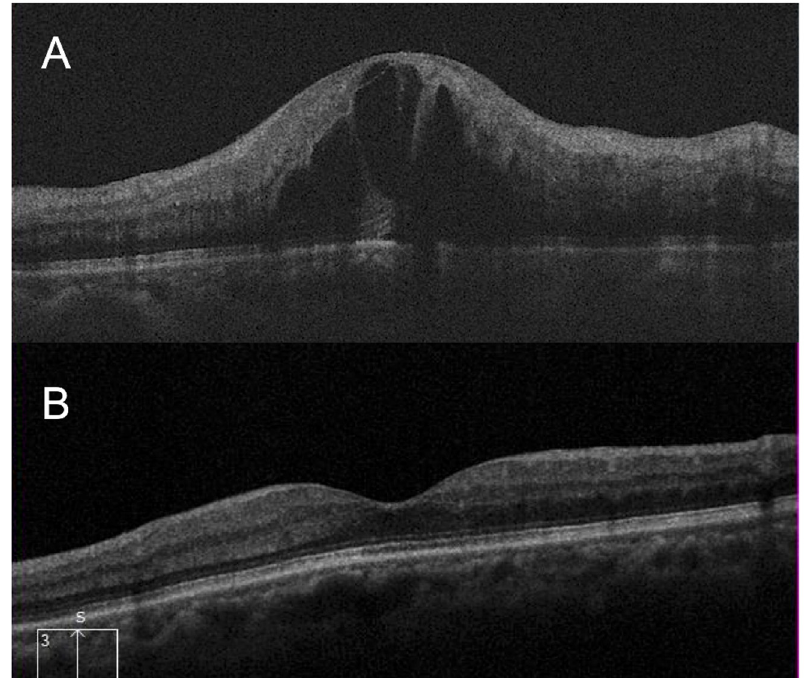
Figure 2. Optical coherence tomography images of a 64-year-old woman with cystoid macular edema secondary to central retinal vein occlusion (CRVO-CME). ( A ) At baseline, CRVO-CME was observed. The logarithm of the minimum angle of resolution (logMAR) best-corrected visual acuity (BCVA), letter contrast sensitivity (LCS) of the affected eye, and the 25-item National Eye Institute Visual Function Questionnaire (VFQ-25) composite score were 0.30, 8 letters, and 52.1, respectively. ( B ) Twelve months after treatment, macular edema was resolved. The BCVA and LCS of the affected eye and the VFQ-25 composite score improved to 0.05, 22 letters, and 88.7, respectively. The improvement in logMAR BCVA was not significant (0.25), but contrast sensitivity and the VFQ-25 composite score significantly improved (14 letters and 36.6, respectively).